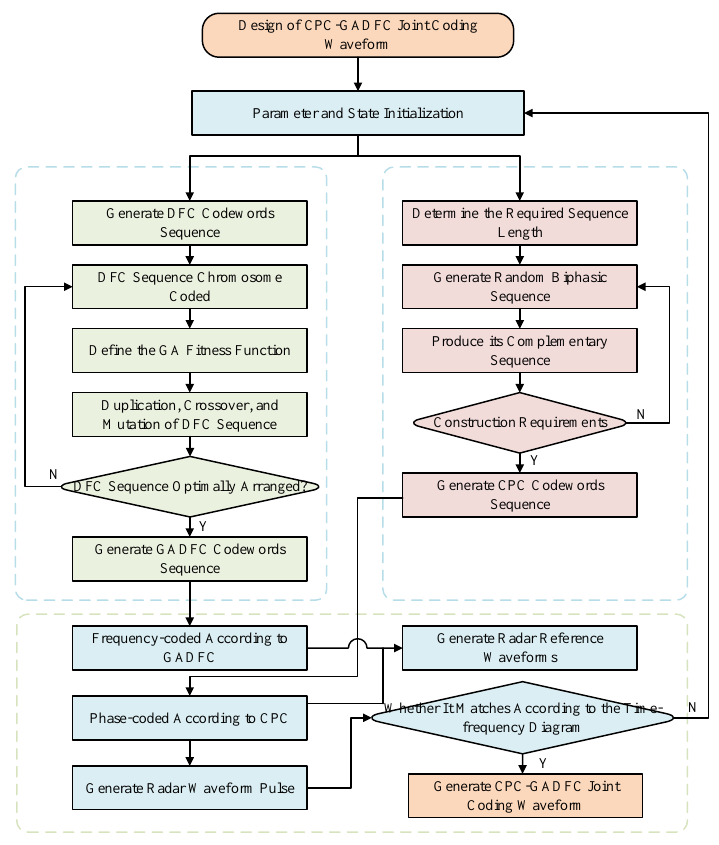
Figure 6. Design Process of CPC-GADFC Joint Coding Radar Waveform Based on